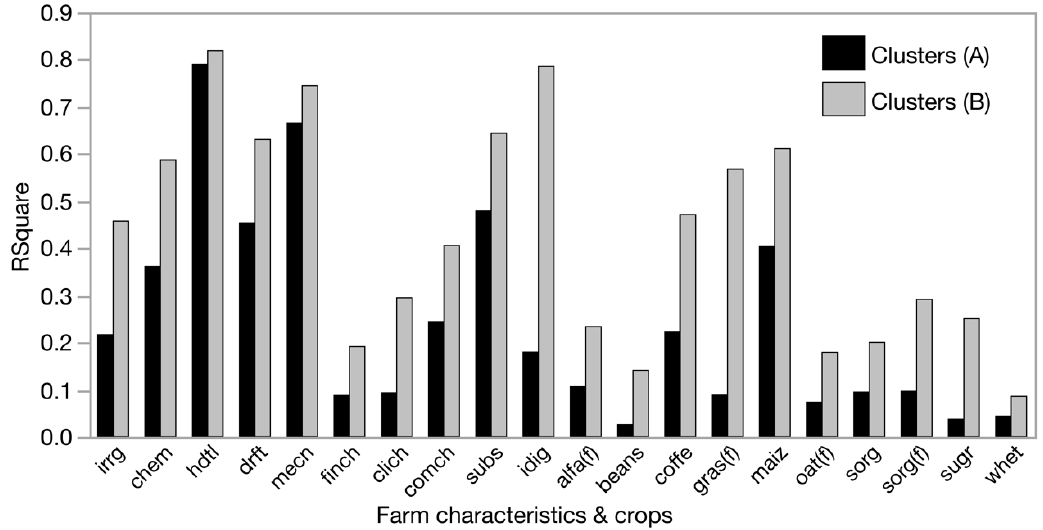
Figure 4. The proportion of the variance explained by each variable per cluster group (A and B).